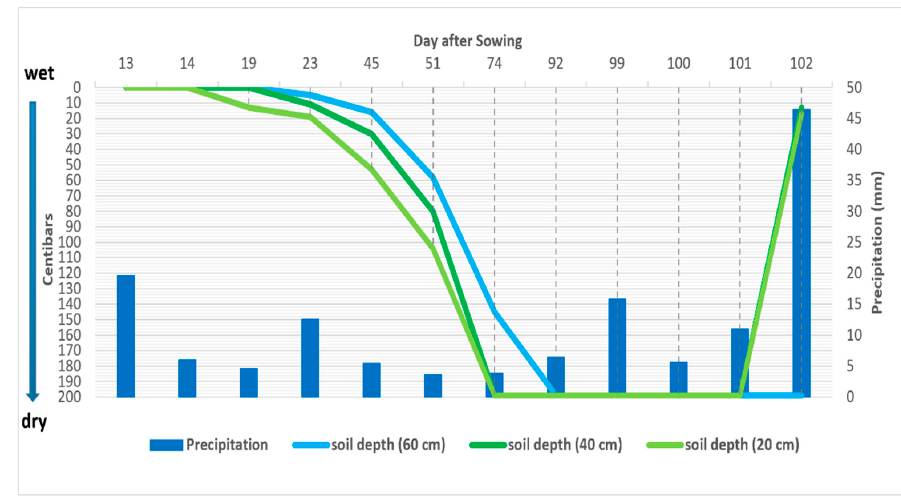
Figure 6. Measurements obtained from Watermark sensors of soil moisture tension measured at 20, 40 and 60 cm of depths (May–September 2017).